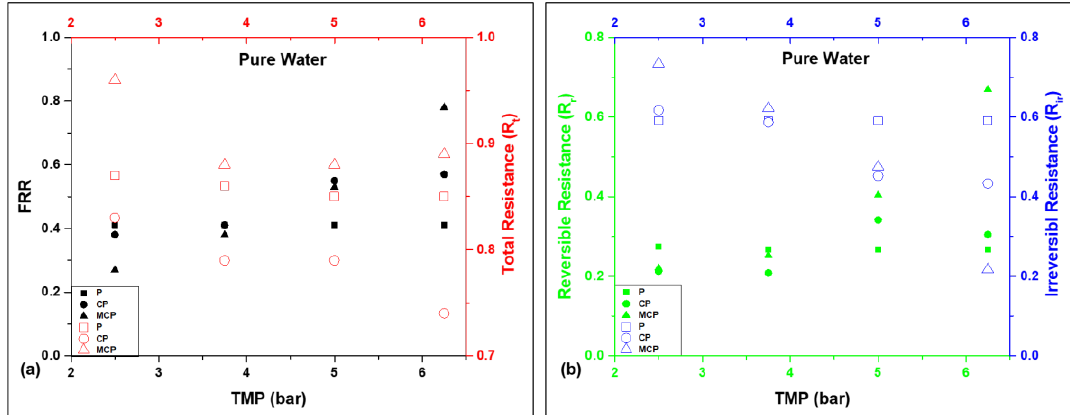
Figure 2. Water flux of the membranes ( a ) P, ( b ) CP, and ( c ) MCP as a function of TMP for pure and contaminated water during BSA filtration for antifouling study.